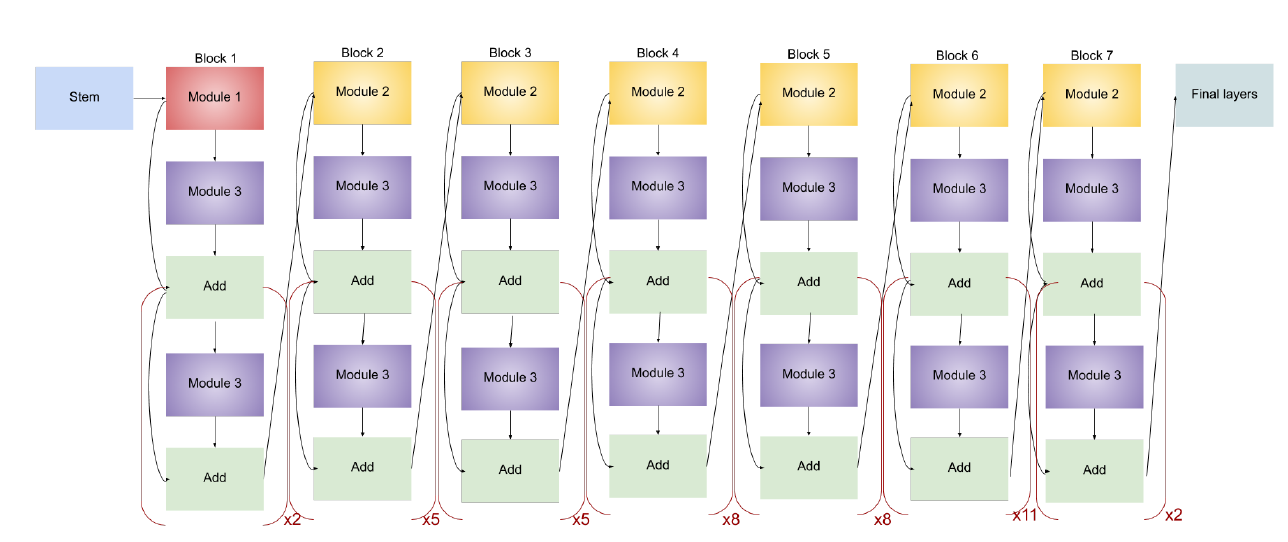
Figure 5. Detailed architecture of EfficientNetB7 neural network architecture